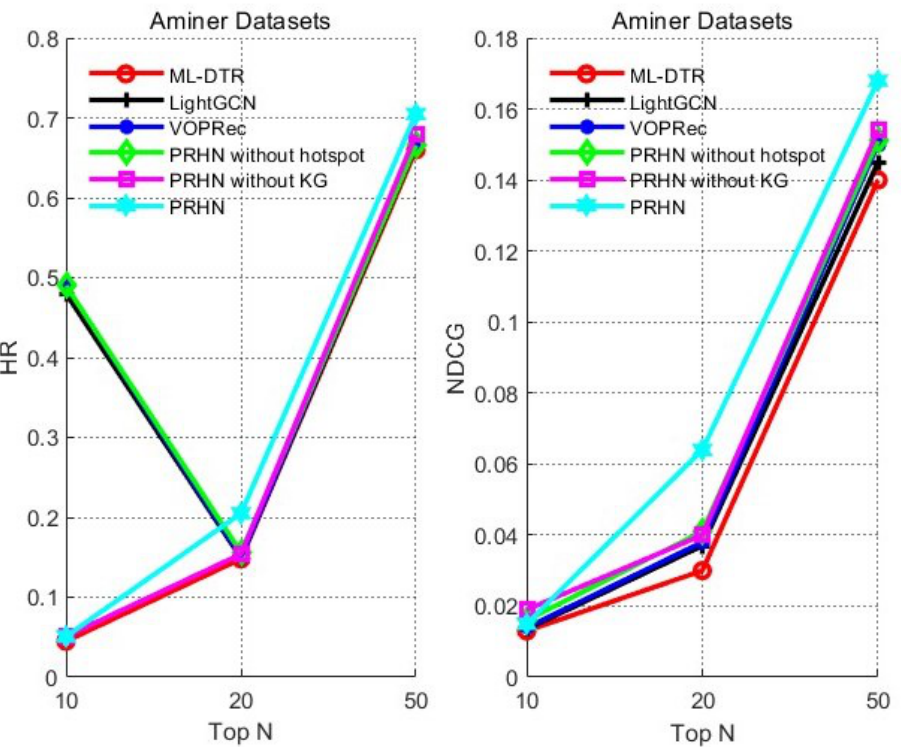
Figure 3. Performance of different models on Aminer datasets.